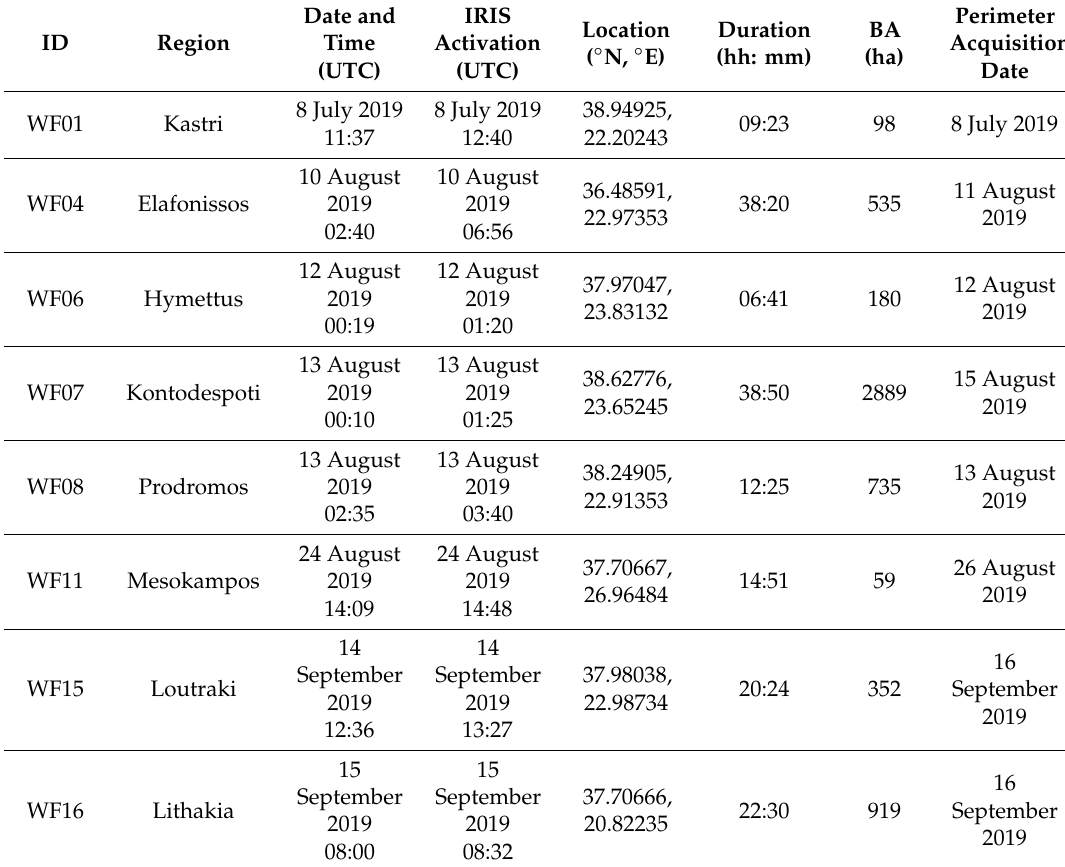
Table 1. Summary of the eight most significant wildfires of the 2019 fire season in Greece, for which IRIS was activated by the Hellenic Fire Corps (HFC) and provided spread predictions. The “Date and Time (UTC)” column reports the actual time of wildfire ignition according to the o ffi cial records of the HFC [47]. The “IRIS activation (UTC)” column reports the time of system activation by HFC o ffi cers (Section